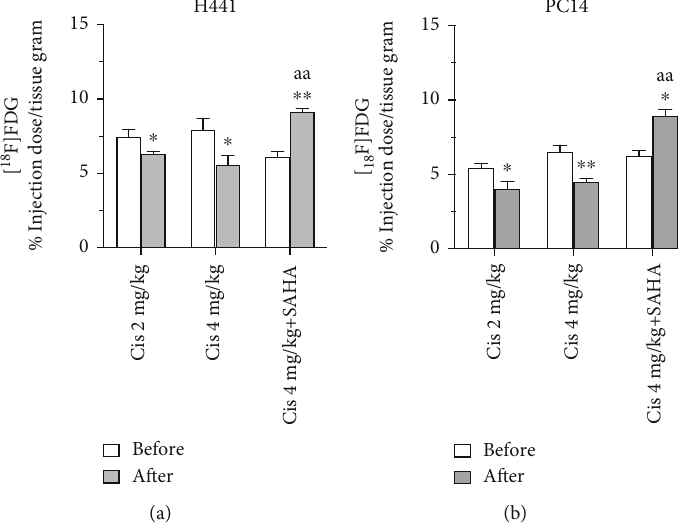
Figure 4: Comparison of [ 18 F] FDG accumulation in xenograft tumors before and after drug administration. Accumulation of [ 18 F] FDG signi fi cantly decreased after administration of cisplatin in Groups A and B, but increased after administration of cisplatin + SAHA in Group C. Data are mean ± SEM . Di ff erent superscript letters indicate signi fi cant di ff erences ( ∗ p < 0 : 05 , ∗∗ p < 0 : 01 compared to the [ 18 F] FDG SUV before drug administration; aa p < 0 : 005 , Group C vs. Group